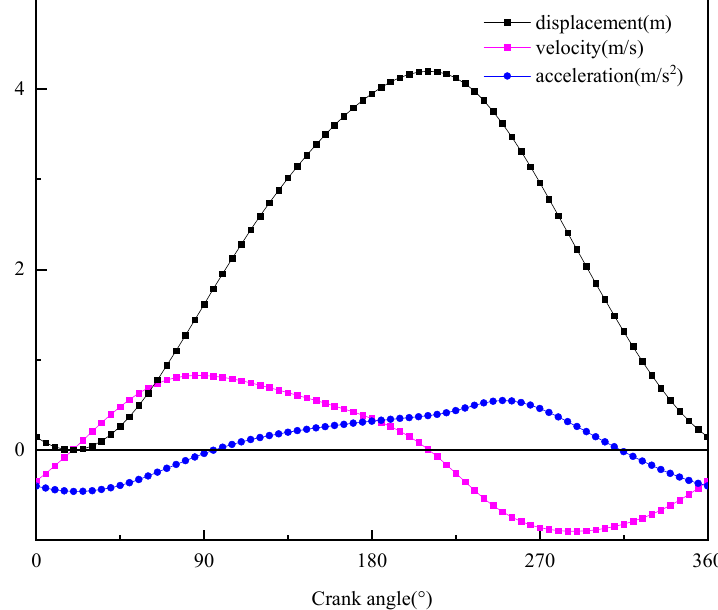
Figure 11. The displacement, velocity, and acceleration of suspension.